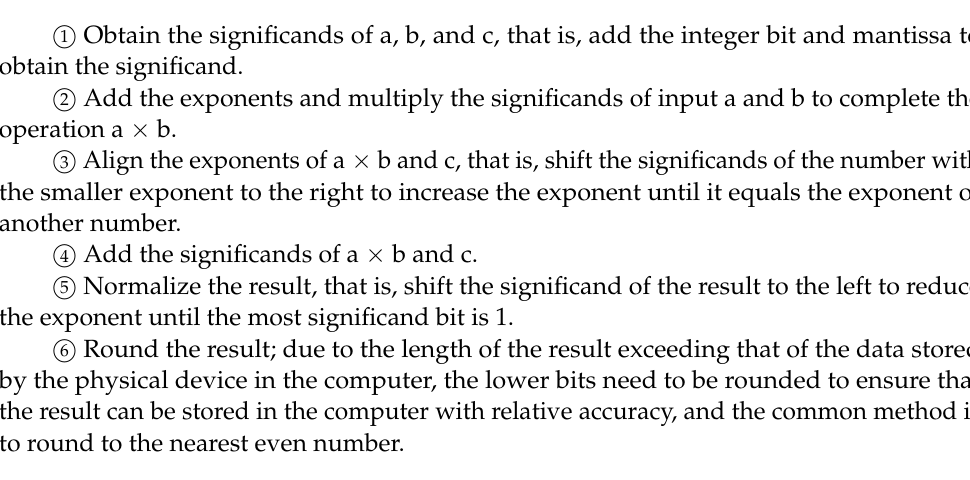
Figure 4. Illustration of the DCIM-FF macro.